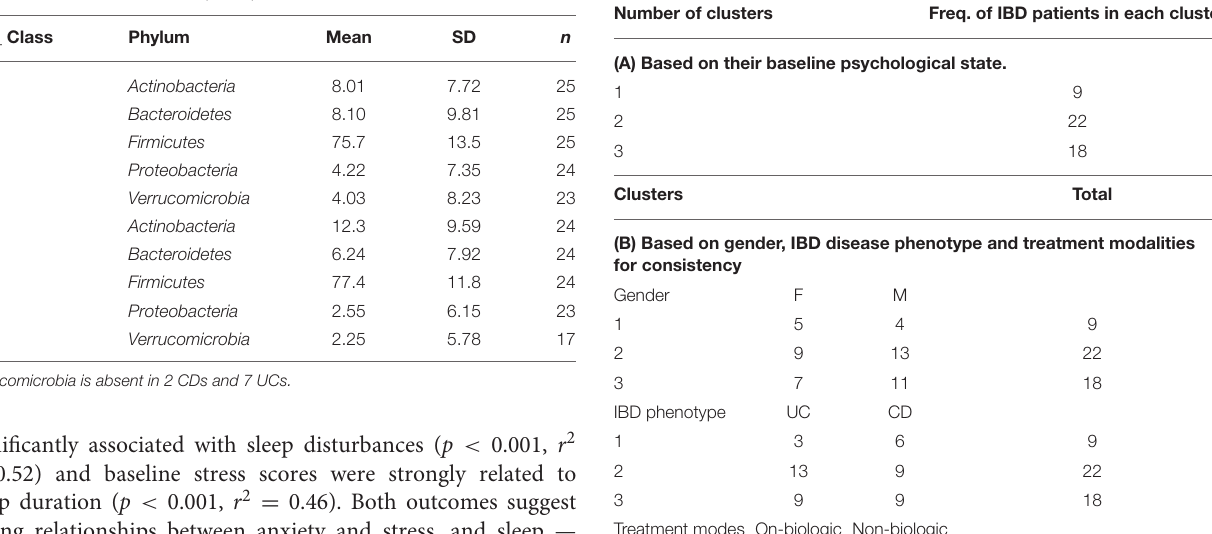
TABLE 3 | Grouped summary IBD class: detailed comparison of the baseline phyla abundance in CD and UC participants.